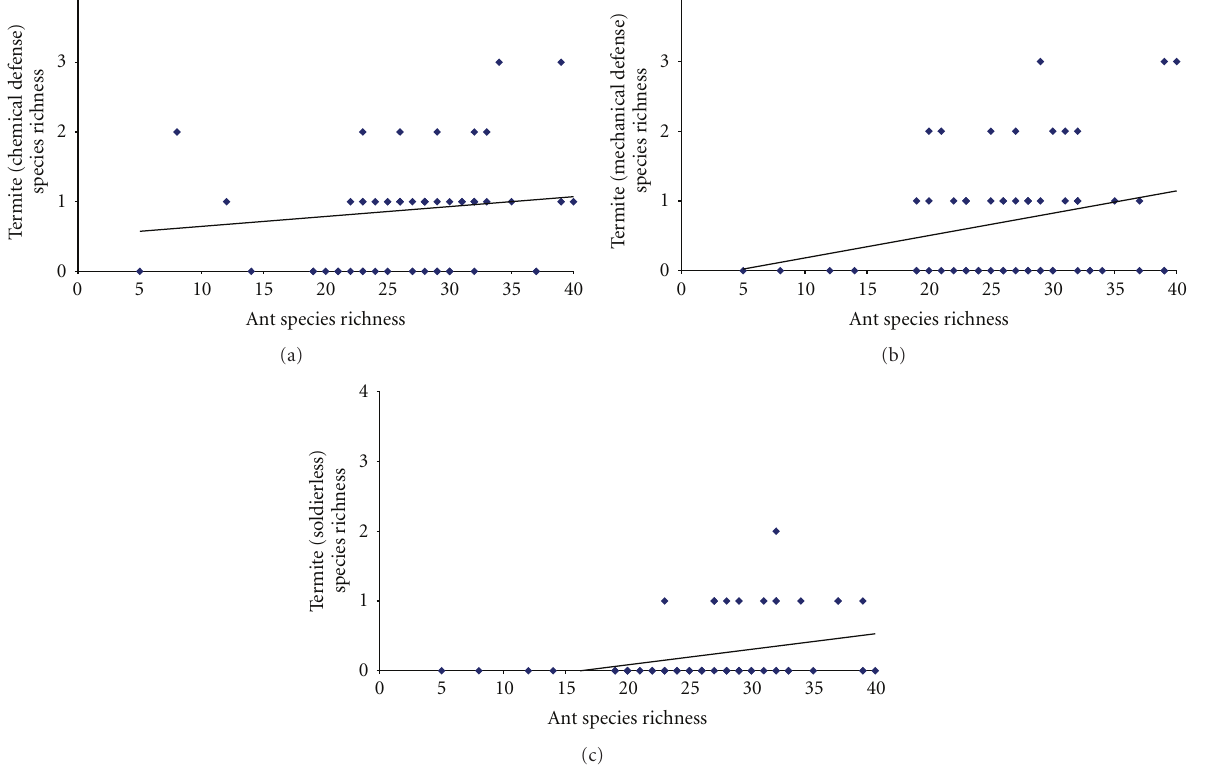
of termites employing these di ff erent predator defenses, a sig-